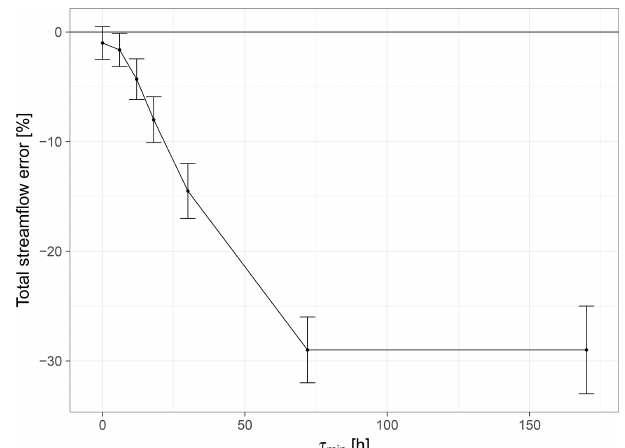
Figure 8. Relationship between the fixed correlation time during precipitation events, τ min , and the total streamflow error, (cid:49) Q , for 6-hourly data resolution in the Murg catchment. Each point corre- sponds to a full inference and prediction procedure. The error bars span two standard deviations of 500 stochastic predictions. E3 cor- responds to τ min = 0 and E2 to τ min = τ max ≈